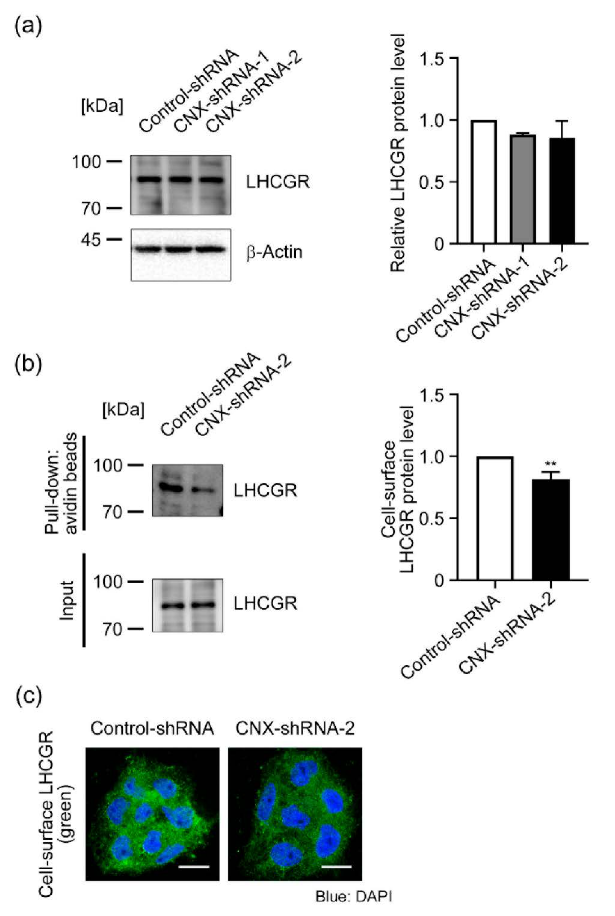
Figure 4. CNX knockdown reduced cell-surface expression of LHCGR in BeWo cells. ( a ) LHCGR expression was analyzed in Control-shRNA, CNX-shRNA-1, and CNX-shRNA-2 cells by means of immunoblot analysis with the specific antibody. The graph shows relative LHCGR levels. Data are shown as means ± SD of three independent experiments. ( b ) Cell-surface proteins were biotinylated in Control-shRNA cells and CNX-shRNA-2 cells, after which biotinylated proteins were collected by using avidin beads. After the avidin beads were washed, biotinylated proteins were eluted from beads and were subjected to immunoblot analysis with the antibody against LHCGR. The graph shows relative cell-surface levels of LHCGR. Data are shown as means ± SD of three independent experiments. ** p < 0.01 vs. Control-shRNA. ( c ) Cell-surface expression of LHCGR in Control-shRNA cells and CNX-shRNA-2 cells was investigated by using immunofluorescence microscopy with the antibody recognizing the extracellular N-terminal domain of LHCGR under non-cell-permeable conditions as described in Materials and Methods. Scale bar: 20 µ